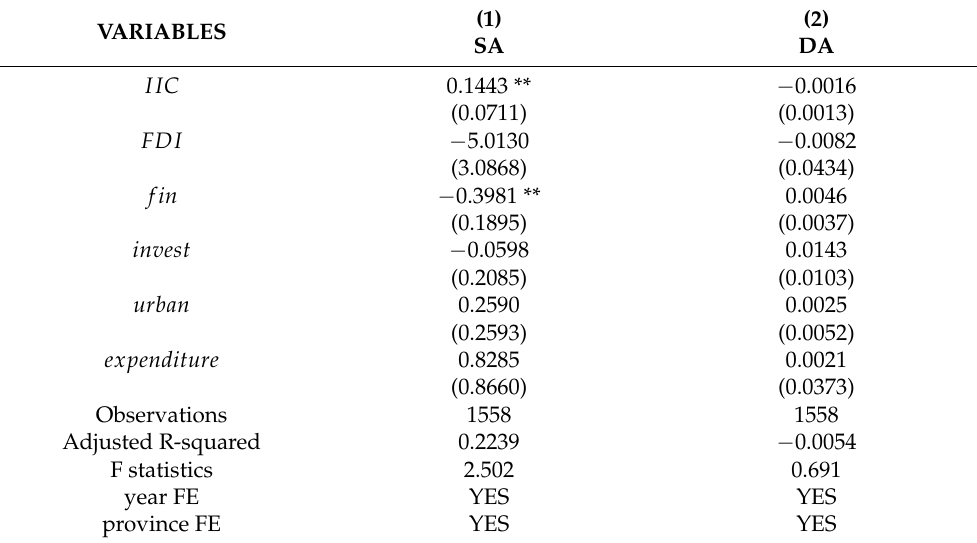
Table 8. Mechanism test: agglomeration